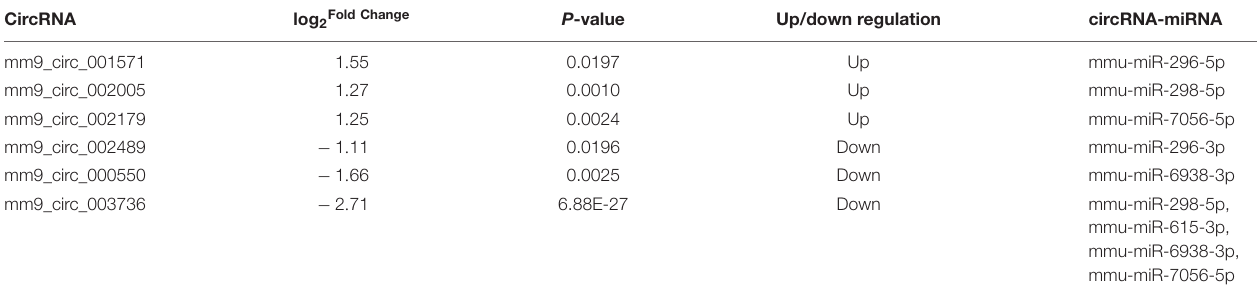
TABLE 2 | DE circRNAs and miRNAs in ceRNA networks under control conditions. CircRNA log 2Fold Change P -value